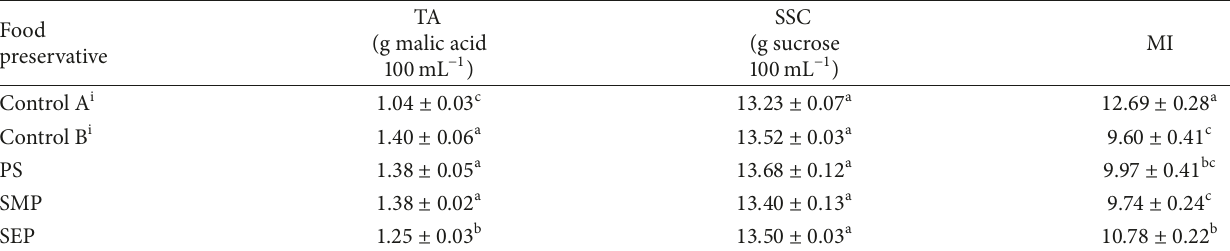
Table2:Titratableacidity(TA),solublesolidcontent(SSC),andmaturityindex(MI)of“Friar”plumsuncoatedorcoatedwithhydroxypropyl methylcellulose-beeswax edible coatings containing potassium sorbate (PS), sodium methyl paraben (SMP), or sodium ethyl paraben (SEP) and stored for 22 d at 1 ∘ C followed by 5 d at 20 ∘